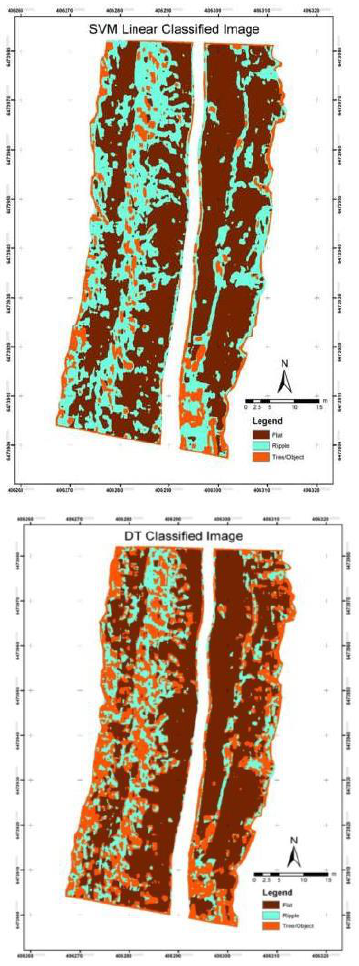
Figure 8: Final classified images: (top) SVM using Gaussian kernel, and (bottom) Decision Tree.